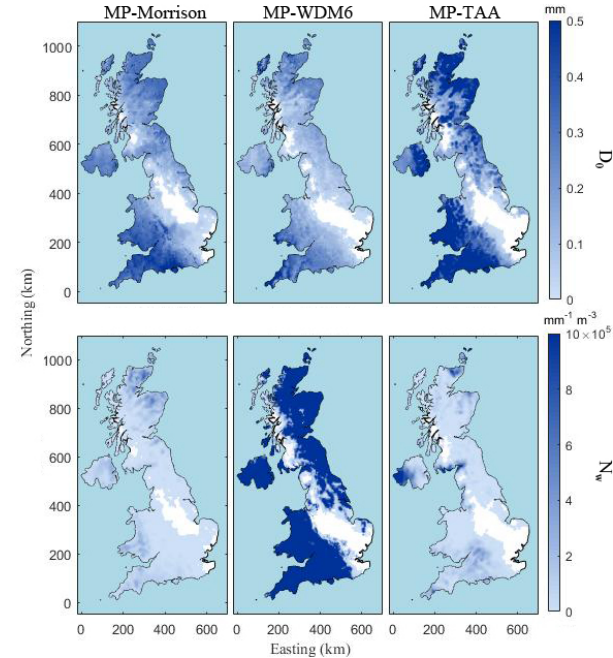
Figure 6. Map of average WRF DSD D 0 and N W (10 January